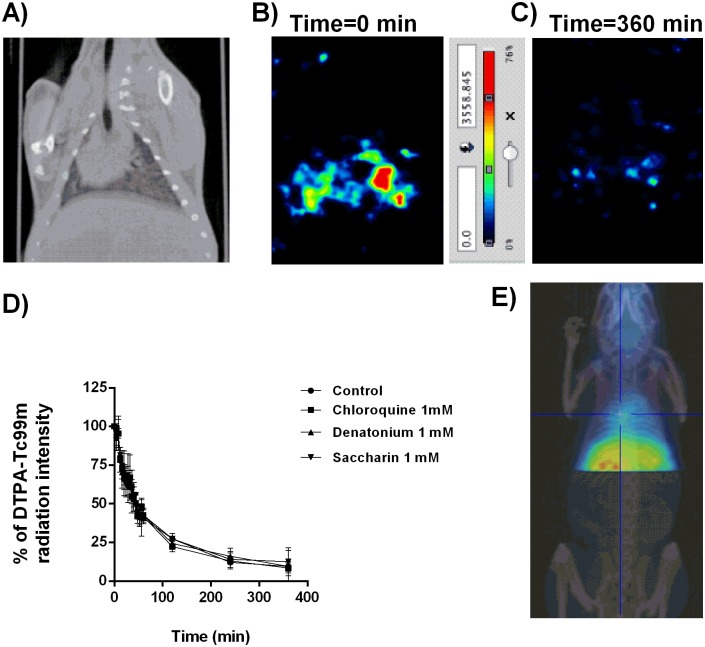
Diethylene-triamine-pentaacetate (DTPA)-Tc99m evaluation as a radiotracer to monitor mucociliary clearance.A) micro-computer tomography (CT) representative image to locate SPECT images. B) SPECT representative image of nebulized DTPA-Tc99m at time 0. C) SPECT representative image of nebulized DTPA-Tc99m at time 360 min. D) Effects of bitter taste agonists chloroquine, denatonium and saccharin on % DTPA-Tc99m radiation intensity. E) Representative image of extra-pulmonary location of DTPA-Tc99m at time 360 min. Representative images of n = 12 guinea pig per experimental condition are showed. Colorimetric intensity scale adjusted for all images is shown. 100% DTPA-Tc99m intensity corresponds to the start of experiments (t = 0min) for all experimental conditions). Results are expressed as mean ± SD. One-way repeated measures analysis of variance (ANOVA): P>0.05. Post hoc Bonferroni test: P>0.05 compared with controls.